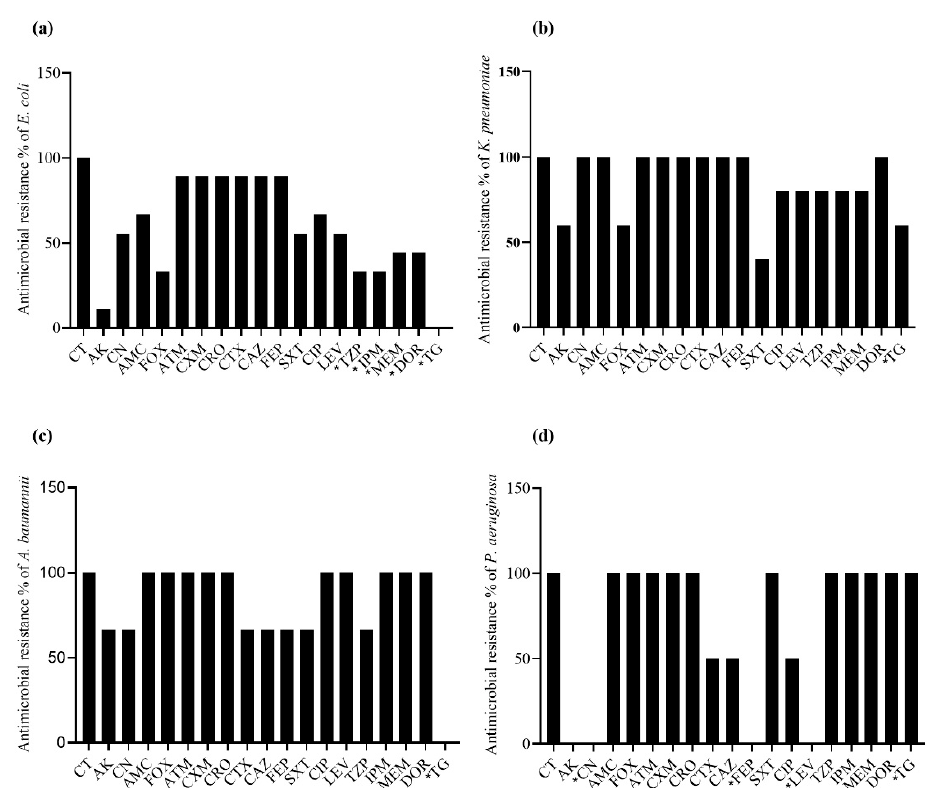
Figure 3. Resistance profile of mcr -harboring gram-negative bacterial isolates ( n = 19). Figure 3a–d show the resistance spectrum of E. coli , K. pneumoniae , A. baumannii and P. aeruginosa , respectively. CT, colistin; AK, amikacin; CN, gentamicin; AMC, co-amoxiclav; FOX, cefoxitin; ATM, aztreonam; CXM, cefuroxime; CRP, ceftriaxone; CTX, cefotaxime; CAZ, ceftazidime; FEP, cefepime; SXT, co- trimoxazole; CIP, ciprofloxacin; LEV, levofloxacin; TZP, piperacillin-tazobactam; IPM, imipenem; MEM, meropenem; DOR, doripenem; TG, tigecycline. * Significant p -values < 0.05.